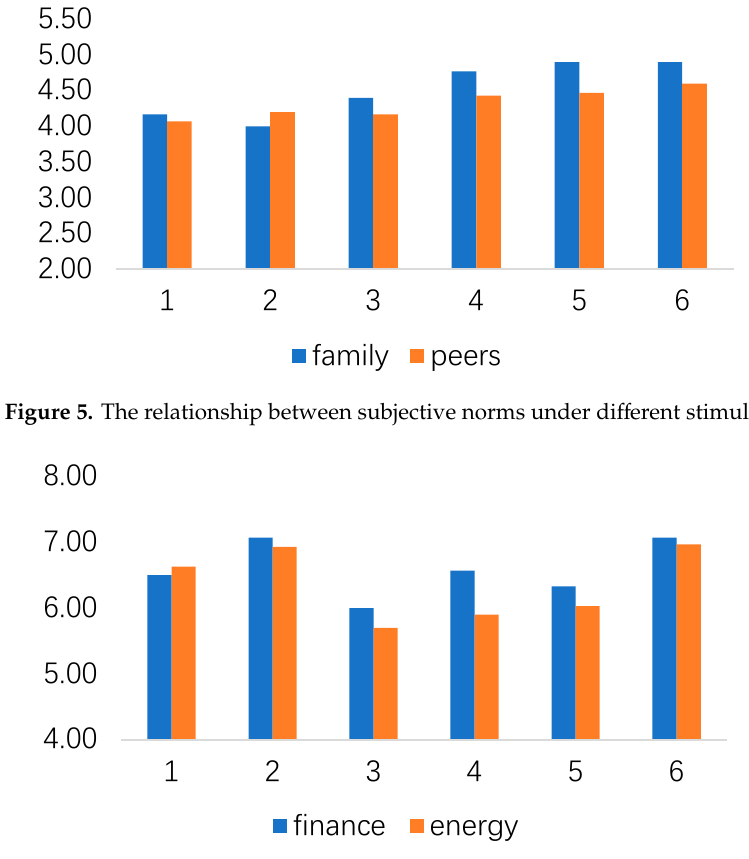
Table 6. The logistic regression on fertility